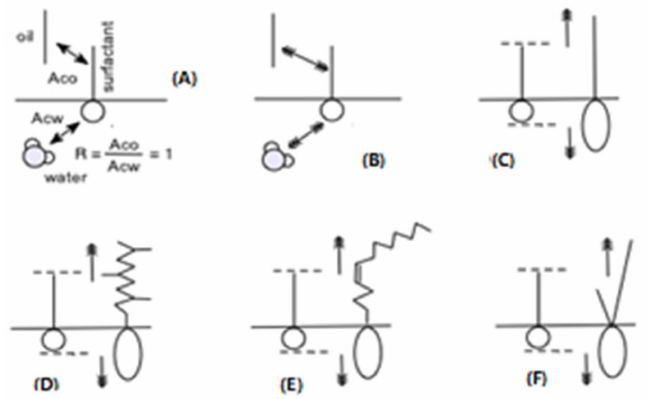
Figure 16. Different kinds of surfactant molecules tail at the interface. ( A ) Optimum formulation in a scan is attained when R = Aco/Acw = 1. Performance improvements at optimum formulation are attained with different ways. ( B ) Increasing the interactions on both sides by changing oil and water characteristics, e.g., lowering the water salinity and decreasing the oil ACN. ( C ) Increasing the interactions on both sides by changing surfactant characteristics, increasing the “size” or importance as far as interactions are concerned, of both head and tail groups. There are additional ways to increase the interaction of the surfactant tail with oil without producing surfactant precipitation: ( D ) branching; ( E ) bending with double bond; ( F ) having a double